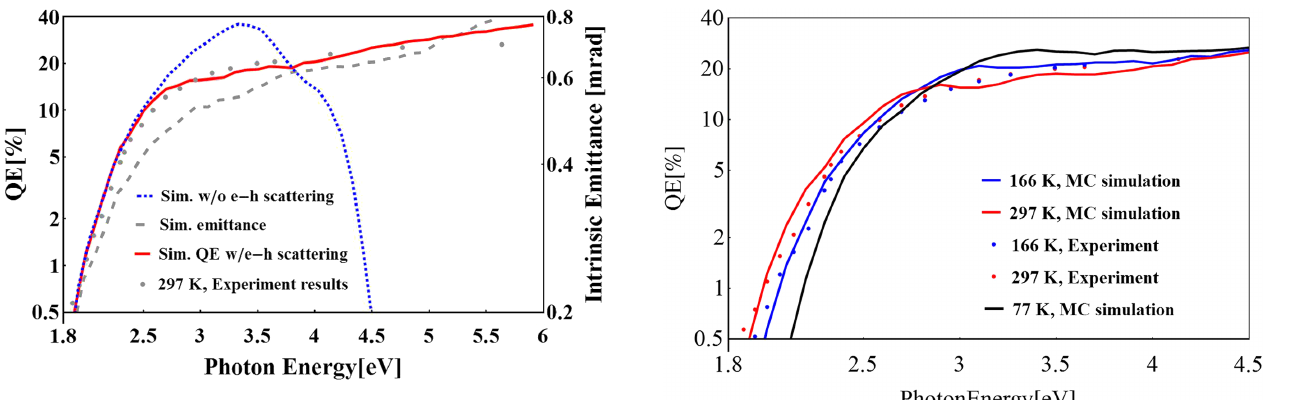
FIG. 10. The results of our simulation of spectral response with and without electron-hole (e – h) scattering, and thermal emittance at room temperature. The dots are the experimental results of the spectral response of the K 2 CsSb photocathode at room temperature.